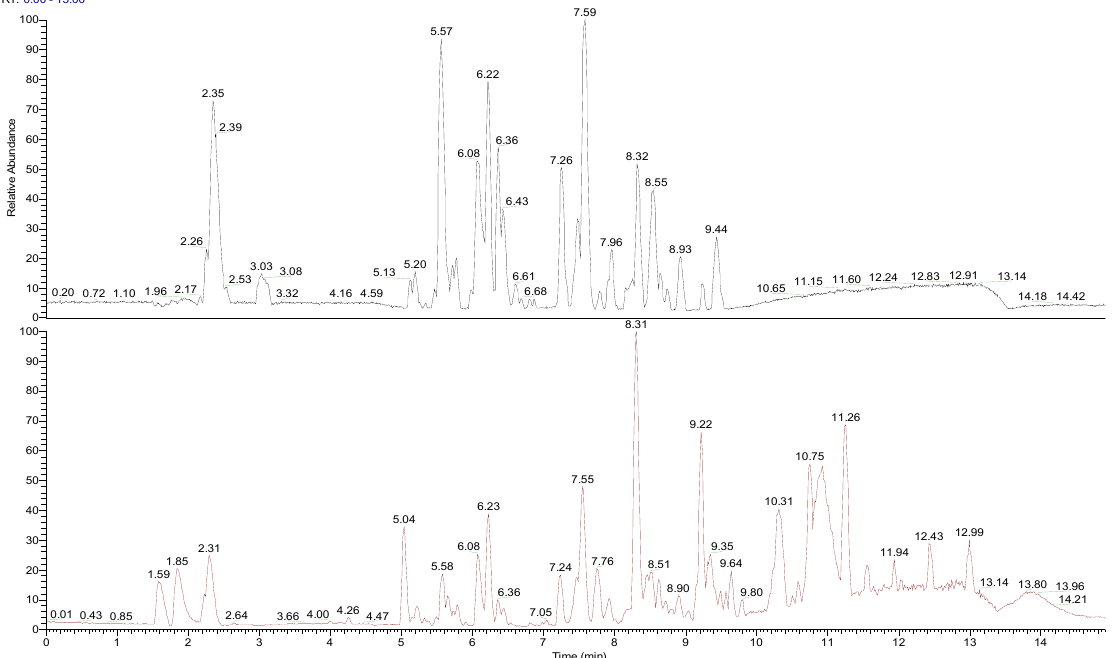
Figure 2. Total ion chromatogram (TIC) for peumo, presented in negative and positive modes. Table 3. Identification of compounds and antioxidant capacity from the methanol extract of peumo fruits, by LC-MS and MS/MS data. The principal peaks were individually analyzed, and the potential molecules were identified. Also, total polyphenol content (TPC), total flavonoid content (TFC), and antioxidant capacity by ORAC methods were determined. GAE, gallic acid equivalent; QE, quercetin equivalent; TE, trolox equivalent.